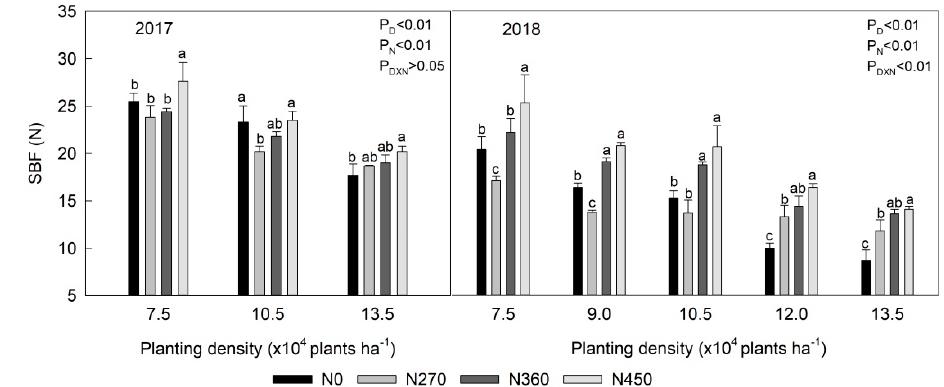
Figure 2. Effect of nitrogen application rate on the stalk breaking force of maize under drip irrigation for different planting densities. N0, N270, N360, and N450 indicate nitrogen application rates of 0, 270, 360, and 450 kg ha − 1 , respectively. Different letters indicate significant difference at the p < 0.05 level under the same planting density. P D , P N and P D × N stand for the p -value of variance analysis for stalk breaking force (SBF) of maize under the effects of planting densities, nitrogen application rates, and their interaction, respectively. The same notation is used in the following figures.